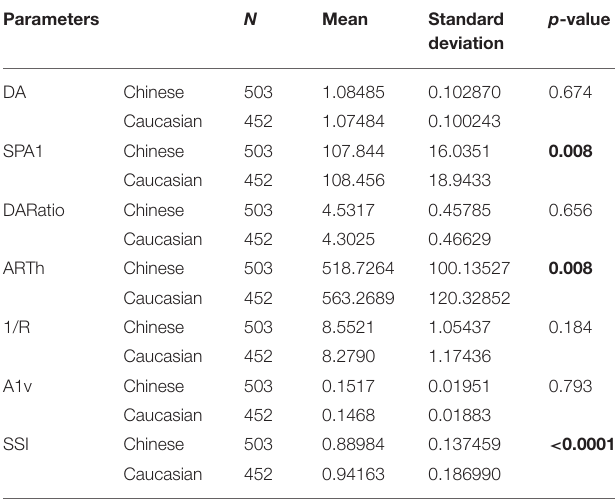
TABLE 2 | Number of cases, mean, standard deviation and p values of Corvis DCRs between Chinese and Caucasian population. Parameters N Standard